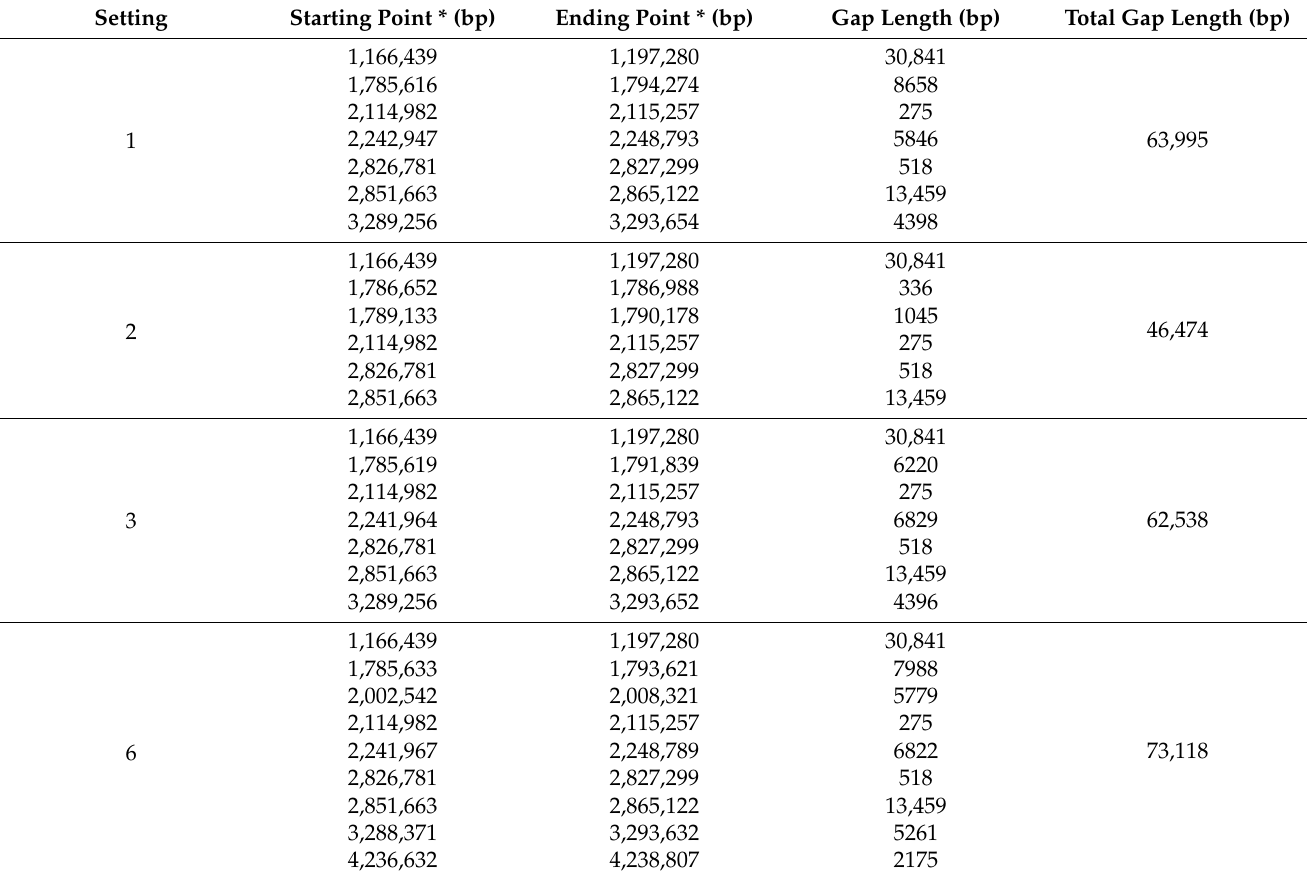
Table 5. Overview of the gaps in the contigs aligned to the